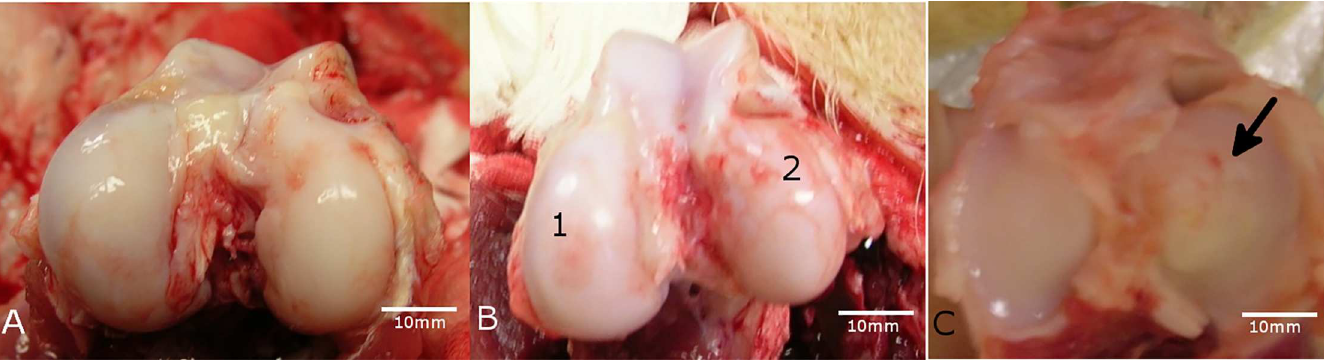
Fig 1. Macroscopic overview. A) The femoral condylesof the ACLR knee joint of animal #8952 showed no visible change/deterioration of the cartilage. B) The femoral condylesof the ACLR knee joint of animal #8955 showed different characteristics in form of a reduced cartilage coating (1) in the lateral condyle and even erosion of the cartilage (2) in the medial condyle. C) The lateral tibia plateau surface of the sham-operated knee joint of animal #8958 showed a slightly rough cartilage surface (arrow). A-C: The scale bars were determinedwith the corresponding x-ray images using the program RadiAnt DICOM viewer (build 3.4.1.13367, retrieved from http://www.radiantviewer.com; October 12th 2016; Medixant (Poznan,